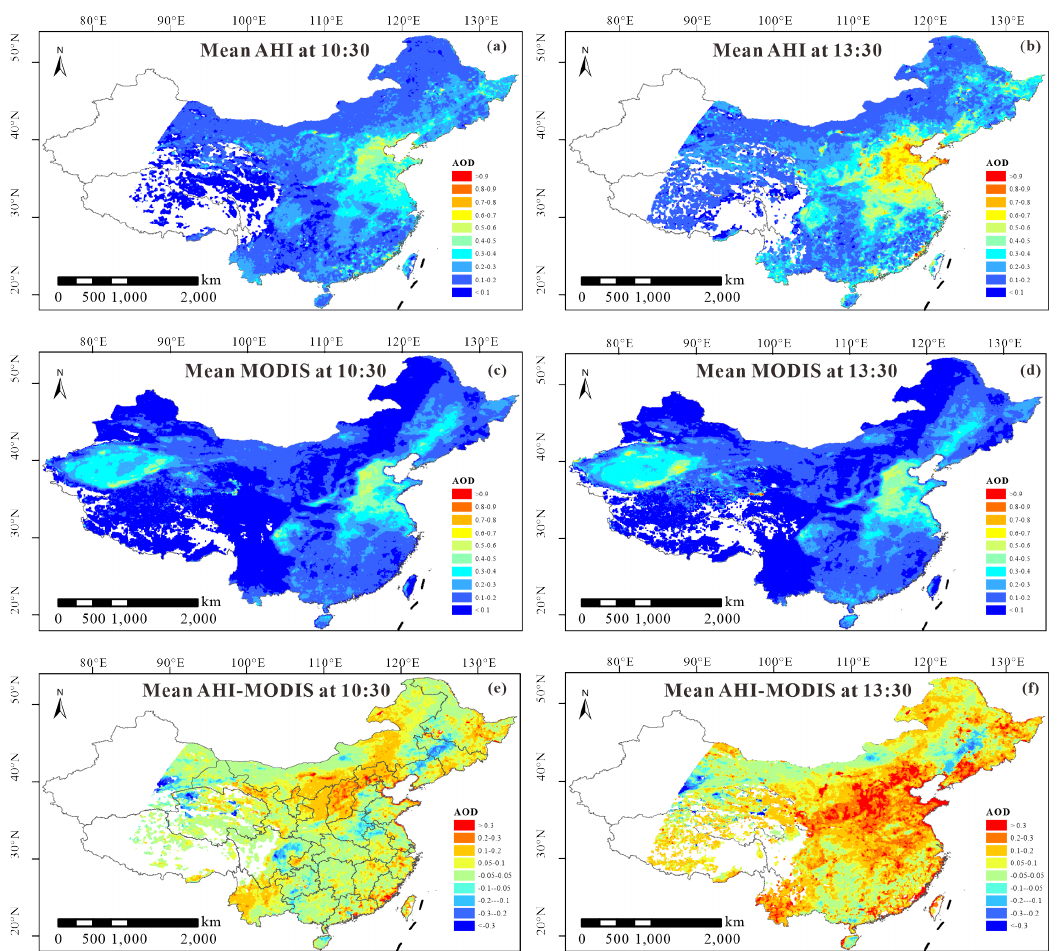
Figure 3. Spatial distribution of average AOD at 500 nm for AHI at 10:30 ( a ) and 13:30 ( b ), MODIS at 10:30 ( c ) and 13:30 ( d ), and the difference between AHI and MODIS at 10:30 ( e ) and 13:30 ( f ) in China during February 2018–January 2019.